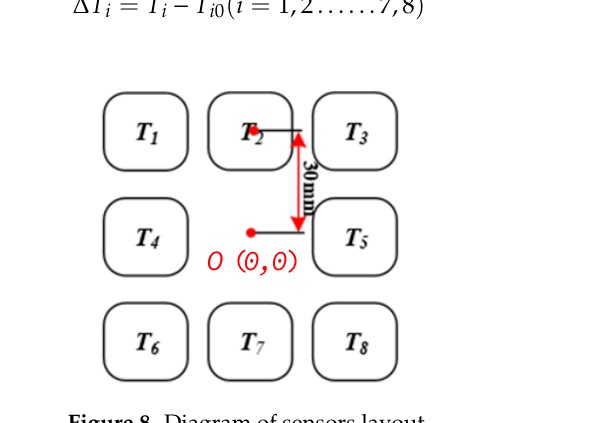
Figure 8. Diagram of sensors layout.